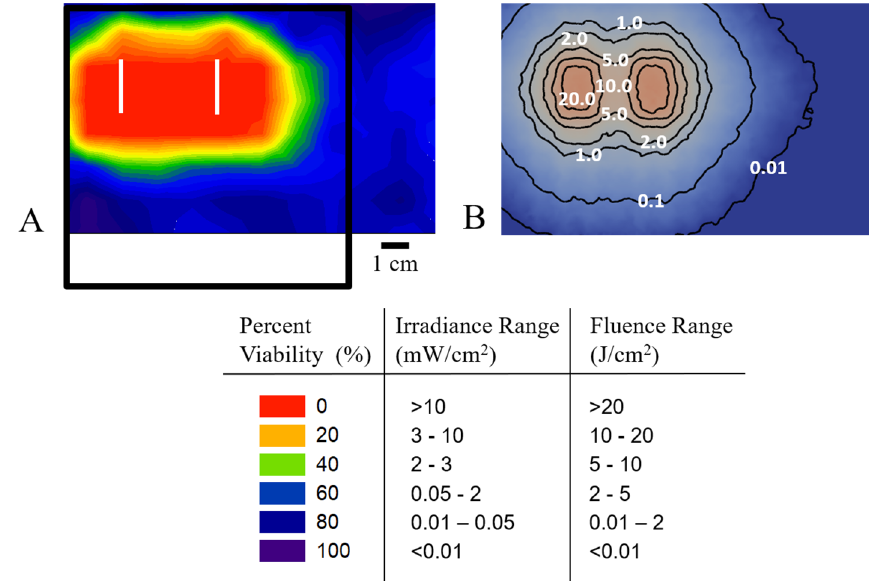
Figure 4. ( A ) Color map of percent cell viability of A549 cells across the 96-well plate. ( B ) The calculated irradiance distribution at the interface of the plate/OSA. The black frame and white lines indicate the OSA and fibers’ position, respectively. The cells were treated with 10 μM TLD1433 and OSA with 532-nm light administration through a 3-mm phantom for 278 s. In vitro experiments were completed in triplicate.